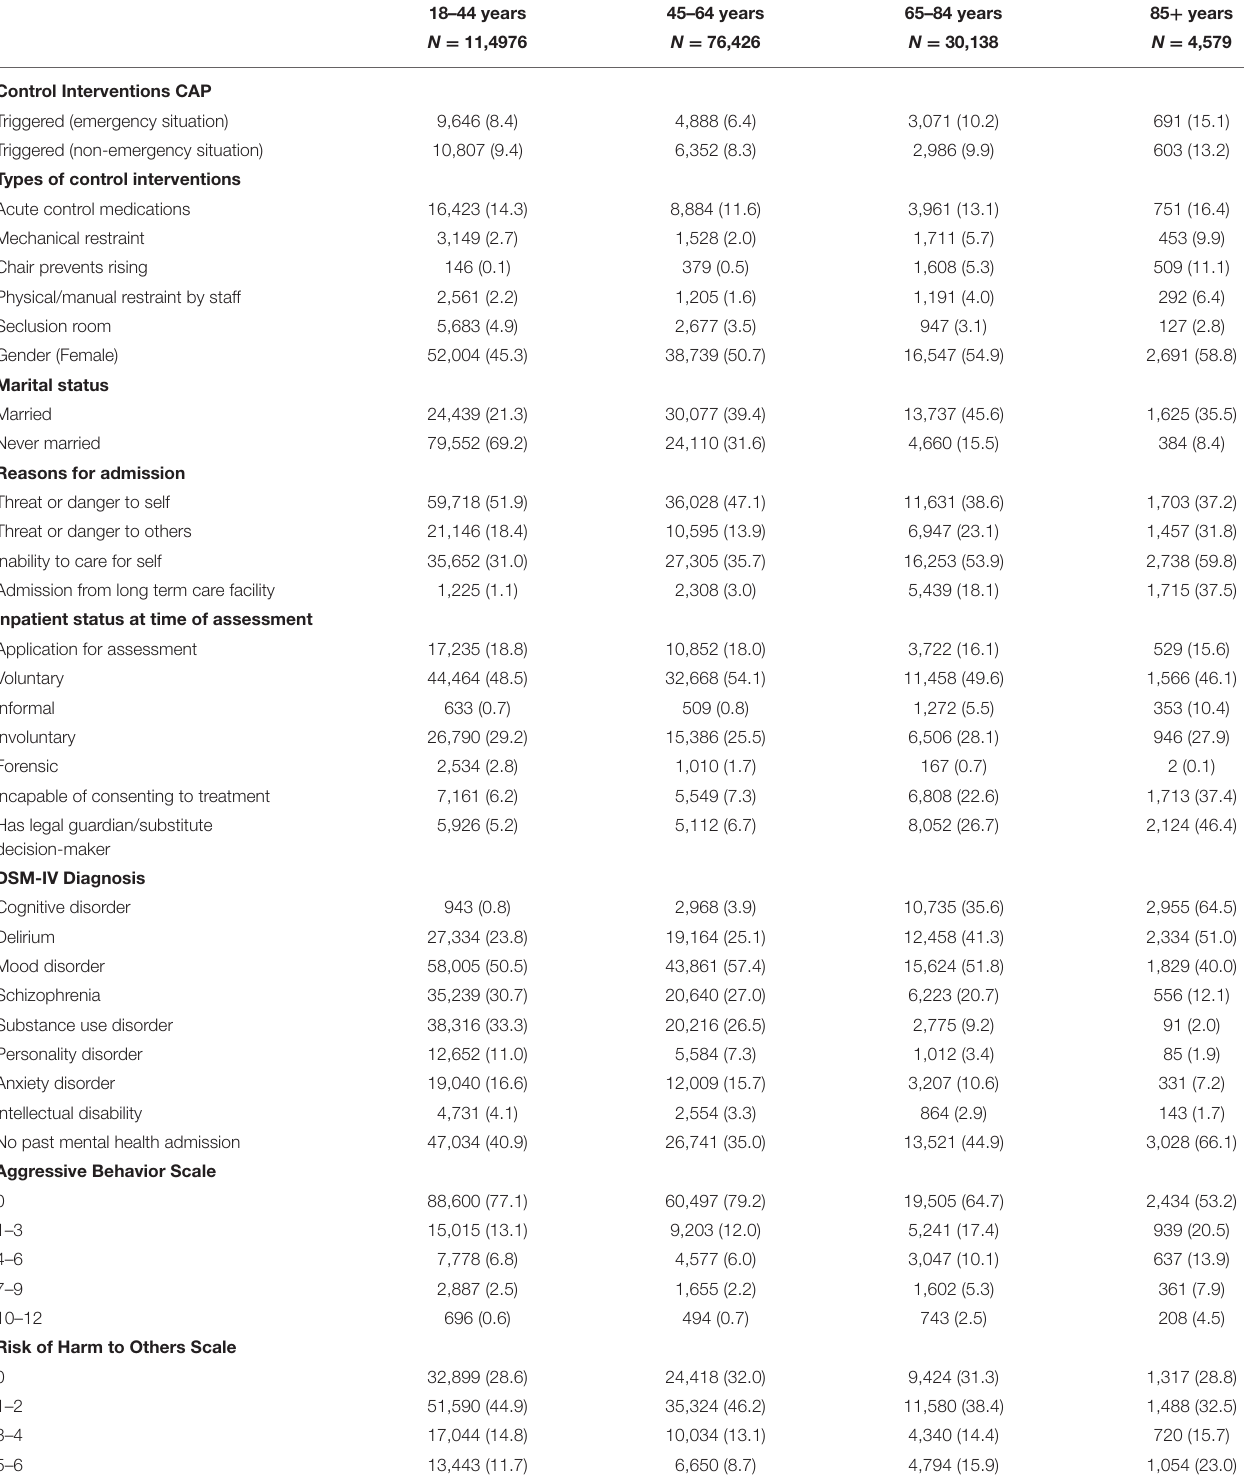
TABLE 1 | Comparison of the use of control interventions, clinical and sociodemographic profiles of psychiatric inpatients across 4 age groups (18–44 years, 45–64 years, 65–84 years, 85 +